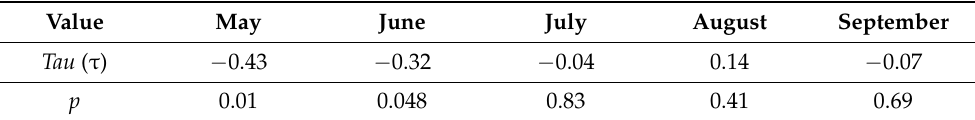
Figure 12. Scatterplots represent the correlation between monthly frequency of BSL (day) and the DJF MEI ( a ) May, ( b ) June, ( c ) July, ( d ) August, and ( e ) September. The slope in black-line denotes direction of the relationship (positive/negative). Table 1. Correlation coefficient, Tau ( τ ) and p -values between the monthly frequency of BSL (day) and the DJF MEI.v2 index.